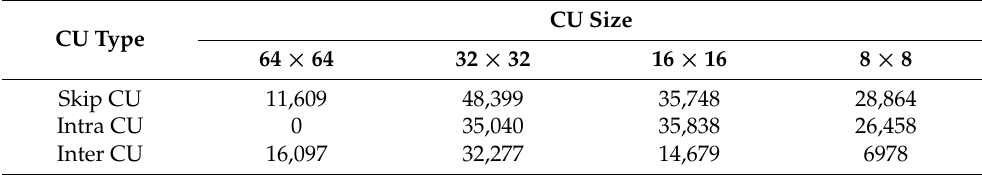
Table 2. Example of CU sizes and types in HEVC encoder’s descriptor.